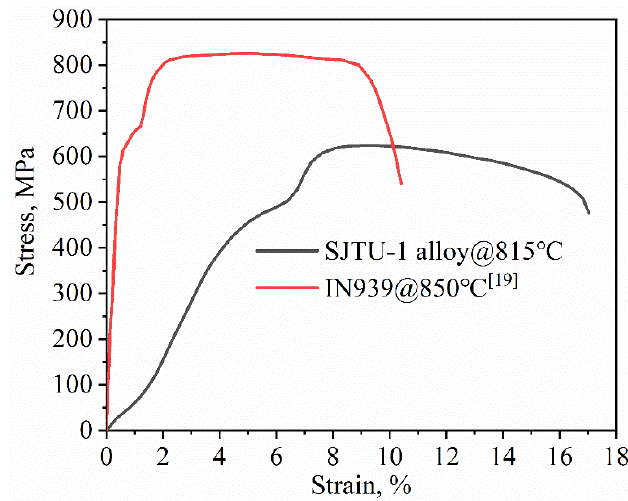
Figure 3. Comparison of the tensile property of SJTU-1 alloy and IN939.